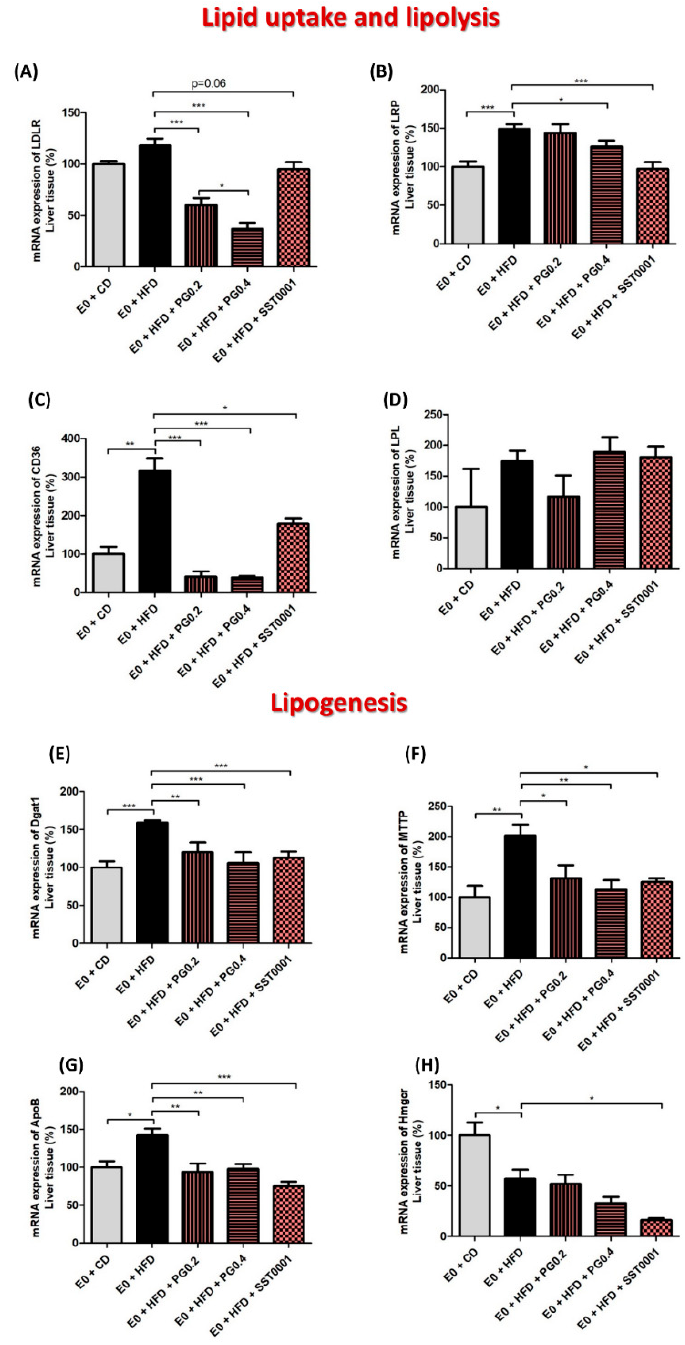
Figure 5. Effect of heparanase inhibitors on lipid metabolism in the liver. mRNA expression of lipid metabolism pathway markers in liver ( A – H ). * p < 0.05, ** p < 0.01, *** p < 0.001.